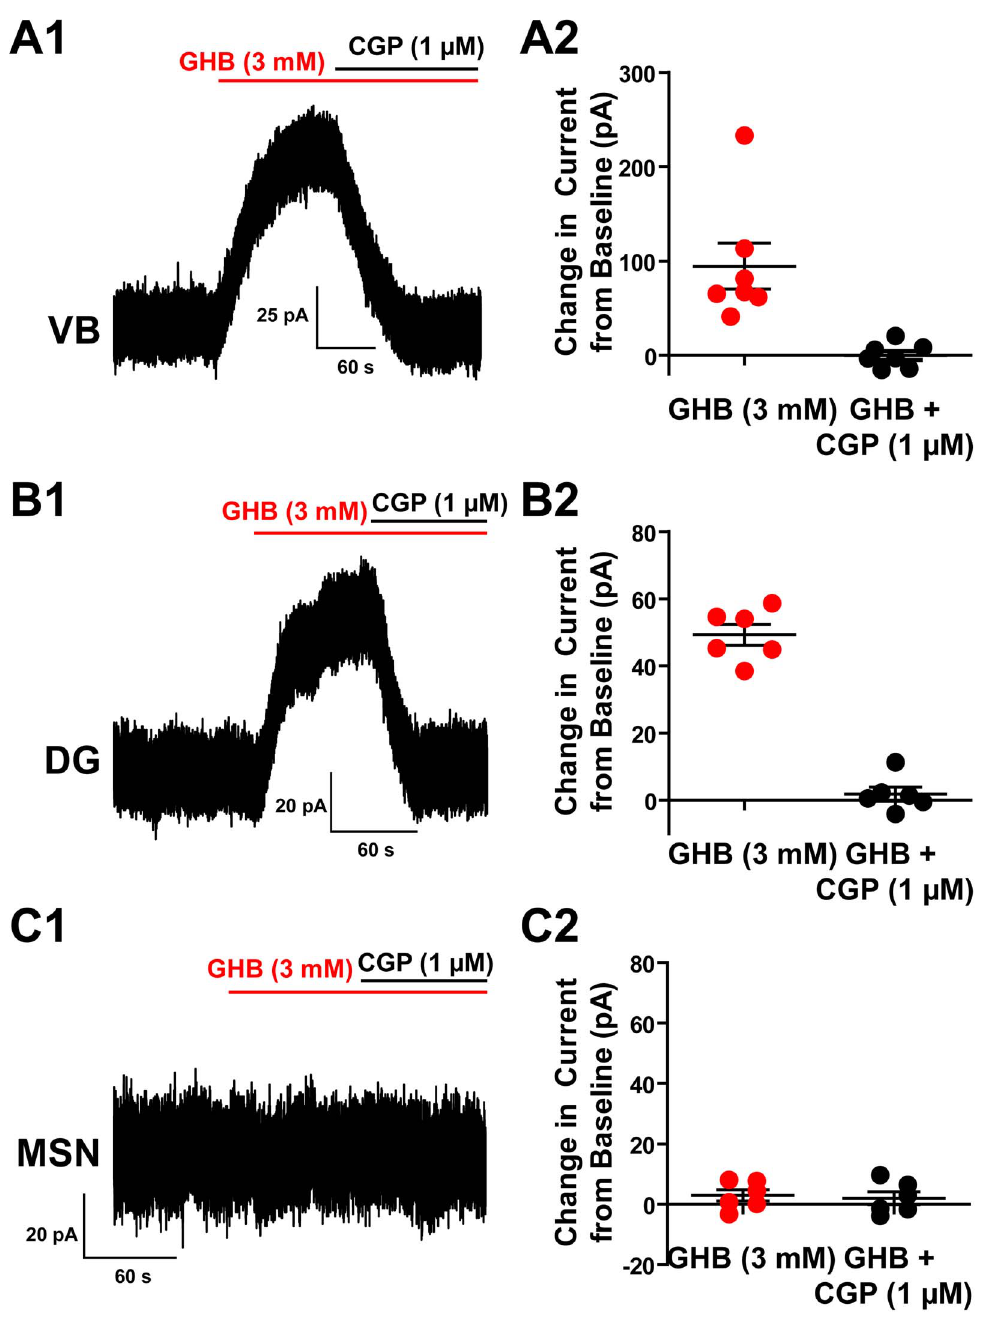
Figure 4. High concentrations of GHB can induce an inward current that is completely abolished by the GABA B antagonist GCP 55845. A1 , Representative recording from a VB thalamic neuron showing the inward current induced by 3 mM GHB, and its blockade by CGP 55845 revealing no residual current. A2 , Group results showing the current induced by GHB and its complete blockade by CGP 55845. B1 , Representative recording from a dentate gyrus (DG) granule cells showing the inward current induced by 3 mM GHB, and its blockade by CGP 55845 revealing no residual current. B2 , Group results showing the current induced by GHB and its complete blockade by CGP 55845. C1 , Representative recording from a striatal medium spiny neuron (MSN) the complete lack of response to 3 mM GHB and CGP 5584. C2 , Group results showing the lack of effect of GHB or CGP 55845. doi:10.1371/journal.pone.0079062.g004 the b 2/3 selective compound etomidate enhances the tonic neurons is partially produced by b 1 and/or b 3 containing current in VB neurons shows that the tonic current is in part receptors [39]. Importantly, the tonic current from mice with mediated by b 2/3 containing GABA A receptors [39]. However, the etomidate insensitive b 2 N265S mutation is still enhanced by given that the tonic current of b 2 2 / 2 mice is only reduced by etomidate, showing that the tonic current is in part mediated by b 3 receptors, however it is unclear whether b 1 containing receptors approximately 50%, it indicates that the tonic current in these